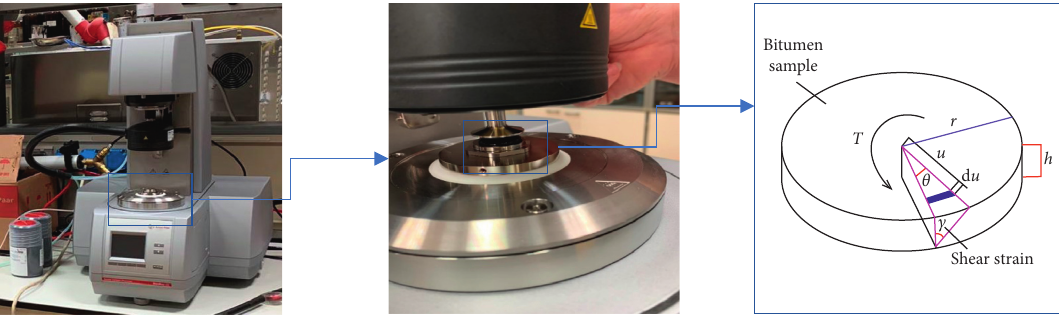
Figure 6: The dynamic shear rheometer used for investigating rheological recovery cycles are run at 0.100 kPa creep stress followed by ten more cycles at 3.200 kPa creep stress.